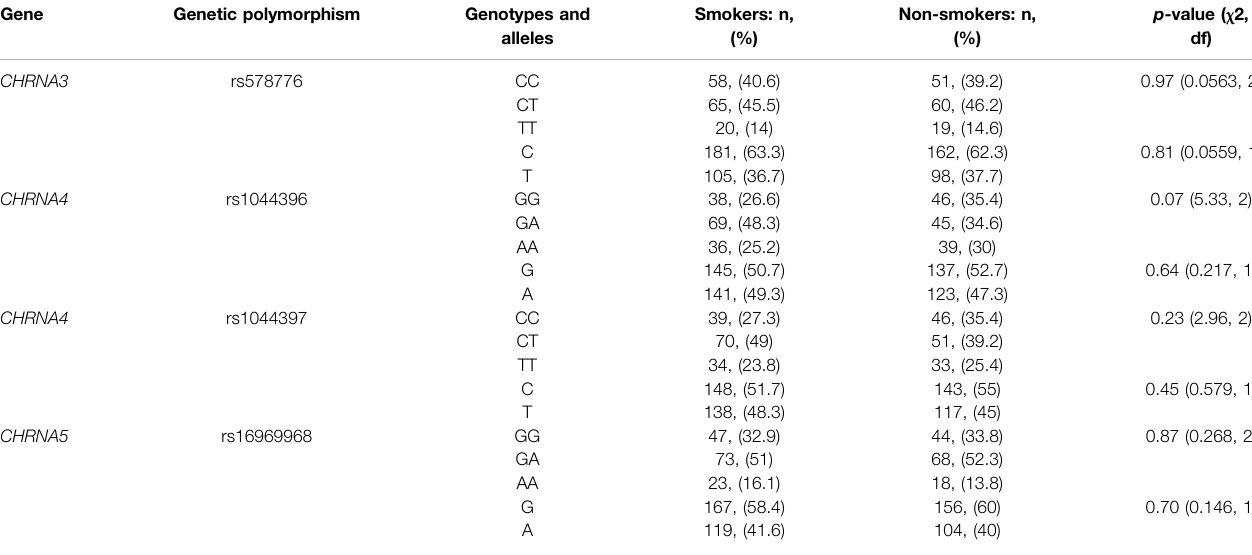
TABLE 3 | Genotype and allele frequencies for the CHRNA3 rs578776, CHRNA4 rs1044396, CHRNA4 rs1044397 and CHRNA5 rs16969968 polymorphisms in smokers vs . non-smokers. Gene Genetic